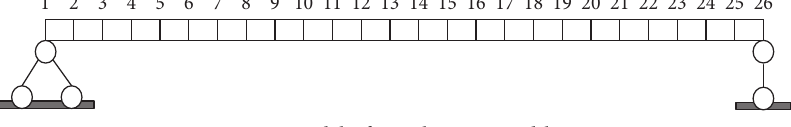
Figure 7: Model of simply supported